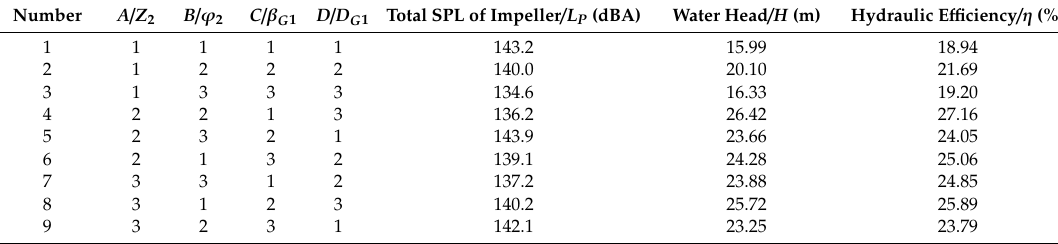
Table 11. Orthogonal experimental schemes and results.